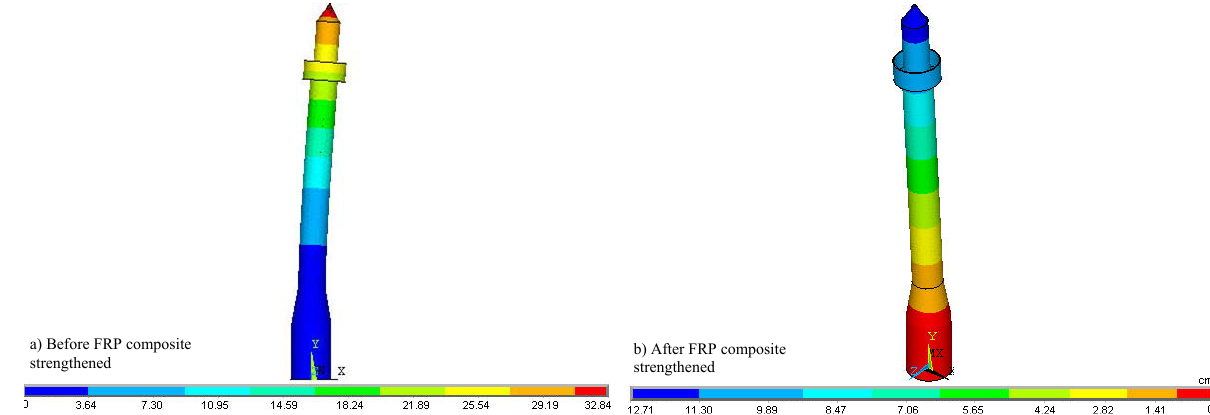
Figure 10 Maximum displacement contours of İ skenderpa ş a historical minaret